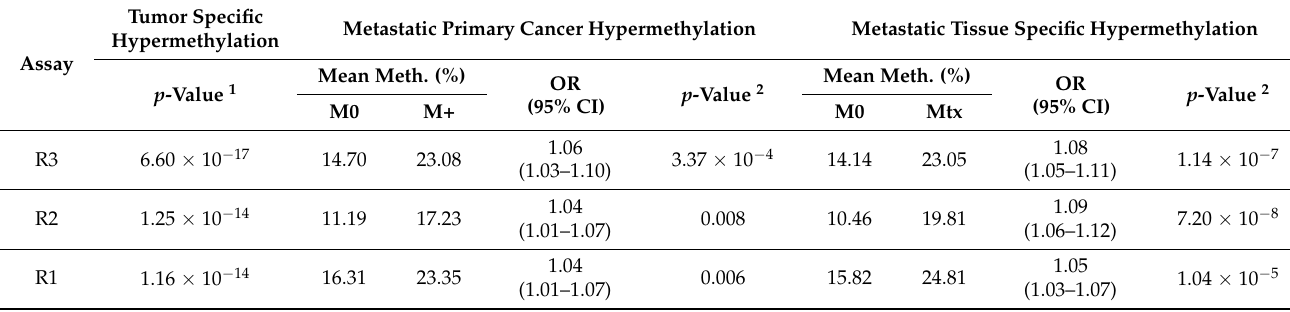
Table 2. Hypermethylation of NKX6-2 regions R1-R3 in renal tissues.